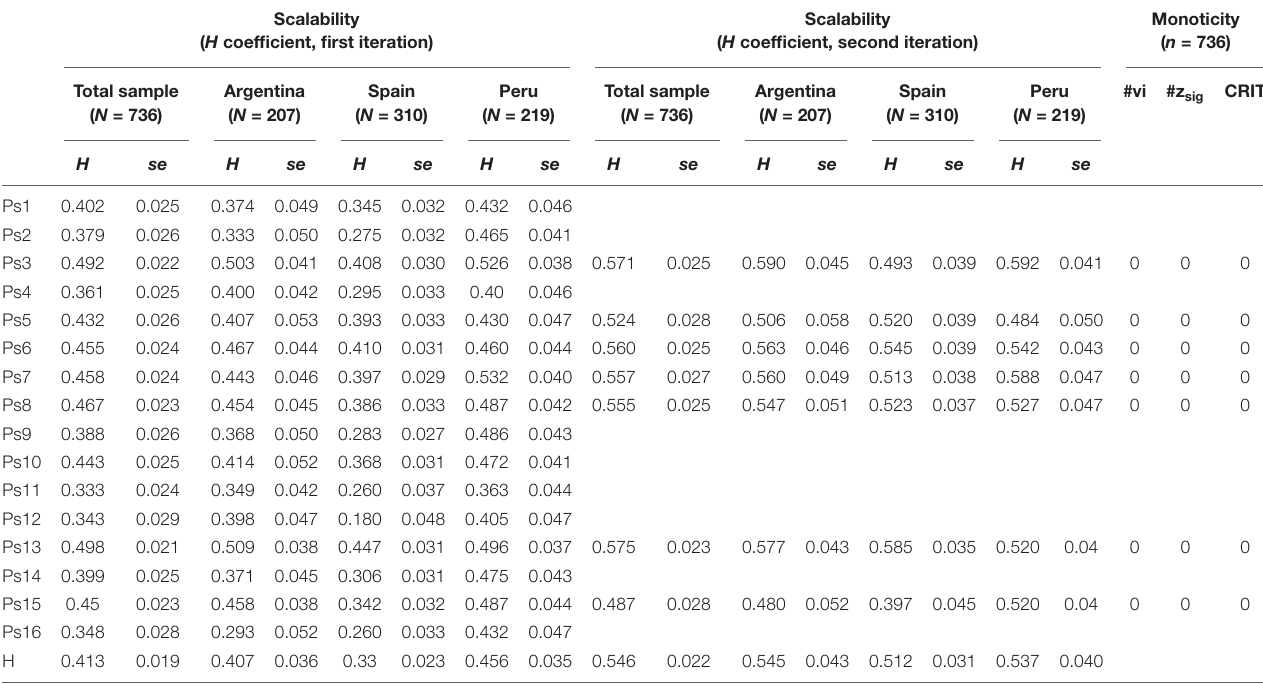
TABLE 3 | Results of Mokken non-parametric analysis (scalability and monoticity). Scalability